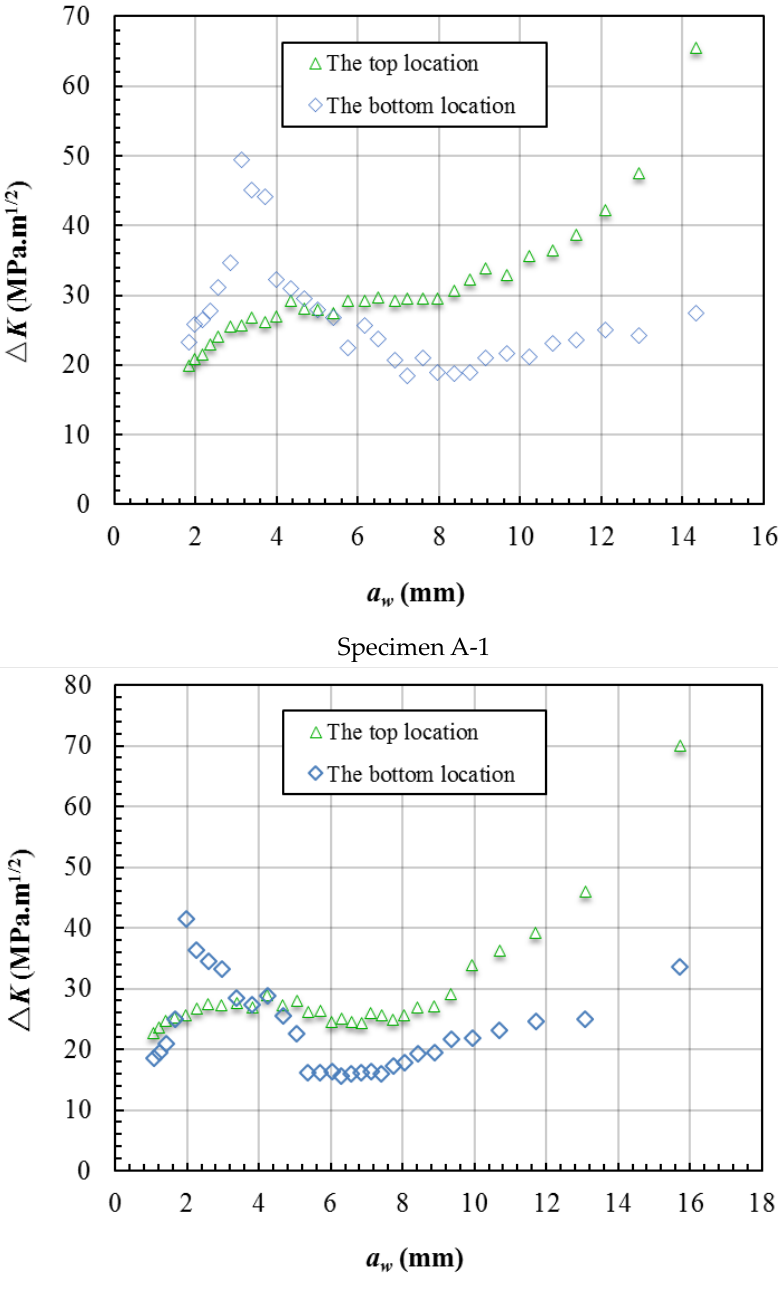
Figure 25. The Δ K at the top and bottom locations varies with the crack length a w. Figure 25. The ∆ K at the top and bottom locations varies with the crack length a